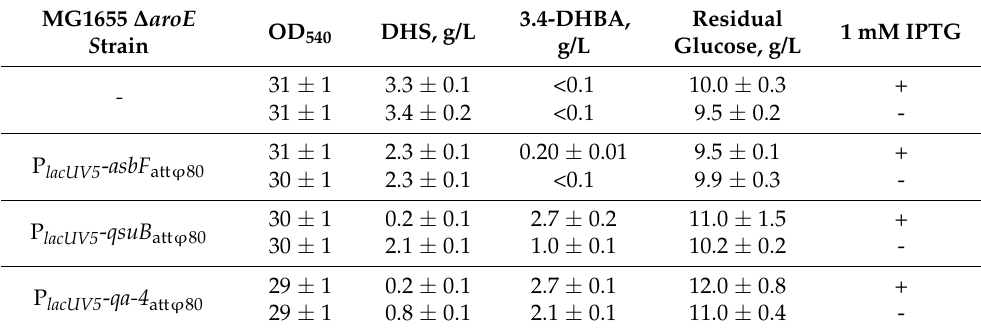
Table 4. TT-fermentation from glucose (40